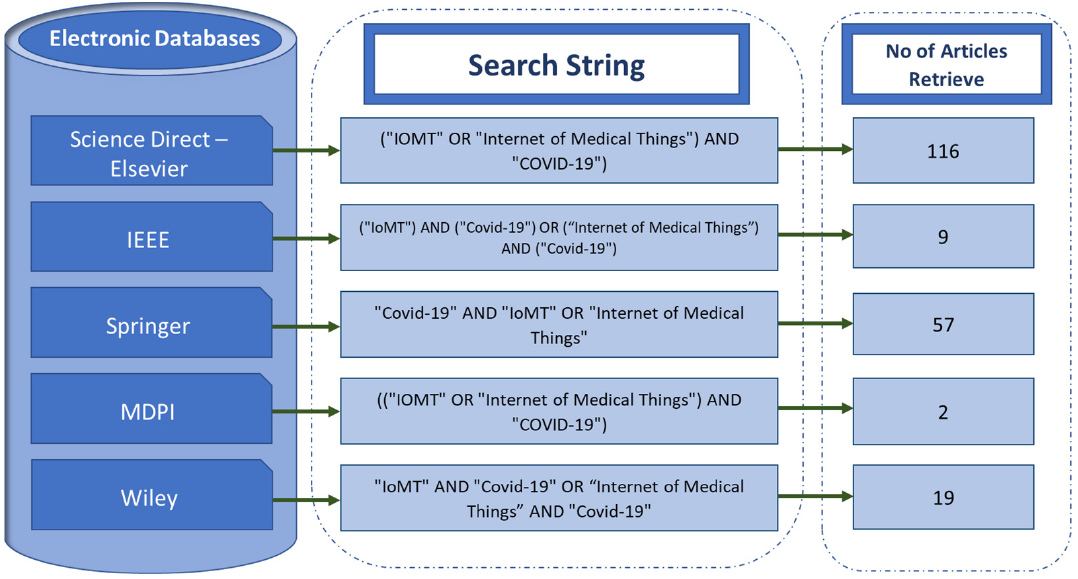
Figure 1. Research publications retrieval data summary.